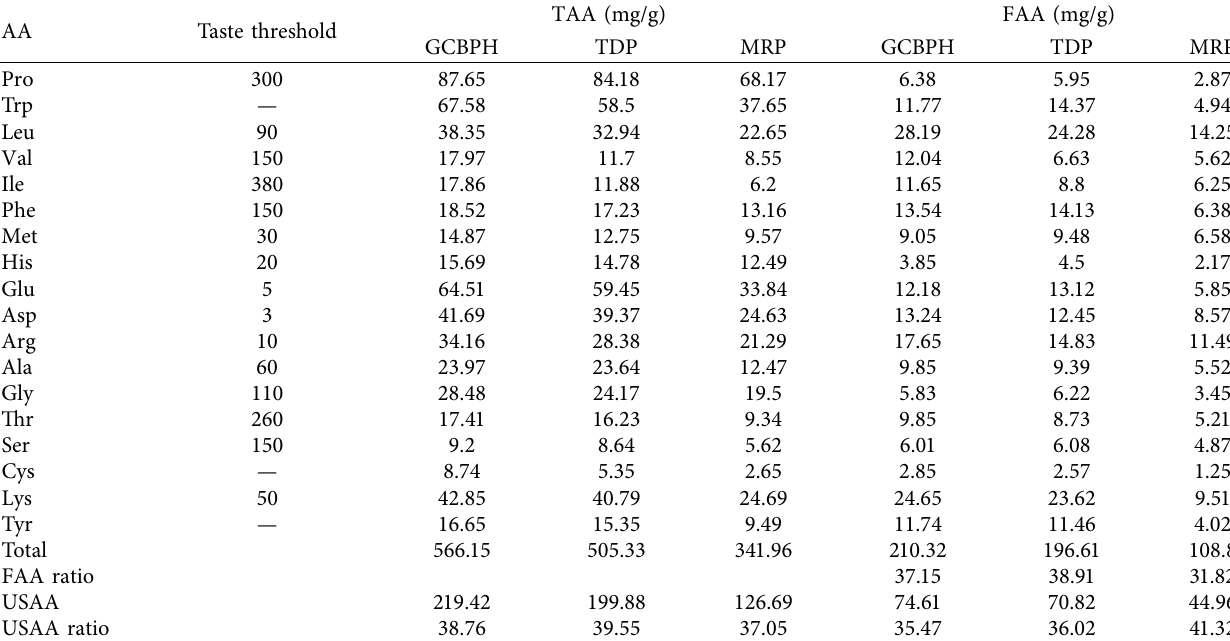
Figure 4: The DPPH radical scavenging rate and ACE inhibitory activity of GCBPH, TDP, and MRP. Means with different superscripts are significantly different ( p < 0 . 05). Table 2: Amino acid composition of GCBPH, TDP, and